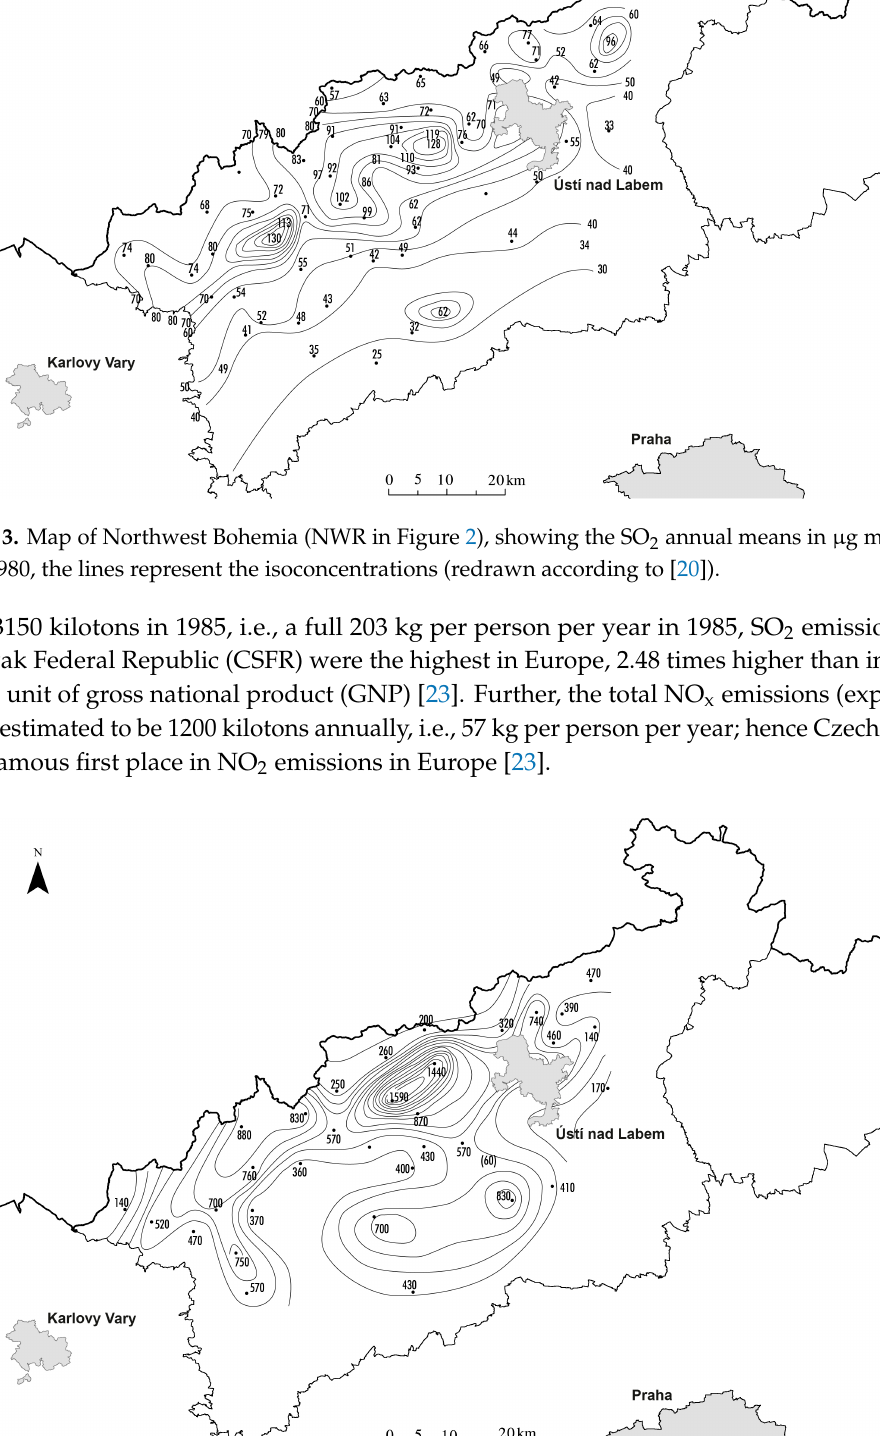
Figure 4. Map of Northwest Bohemia (NWR in Figure 2), showing the SO 2 daily mean in µg m − 3 on 16 January 1982, the lines represent the isoconcentrations (redrawn according to [20]).